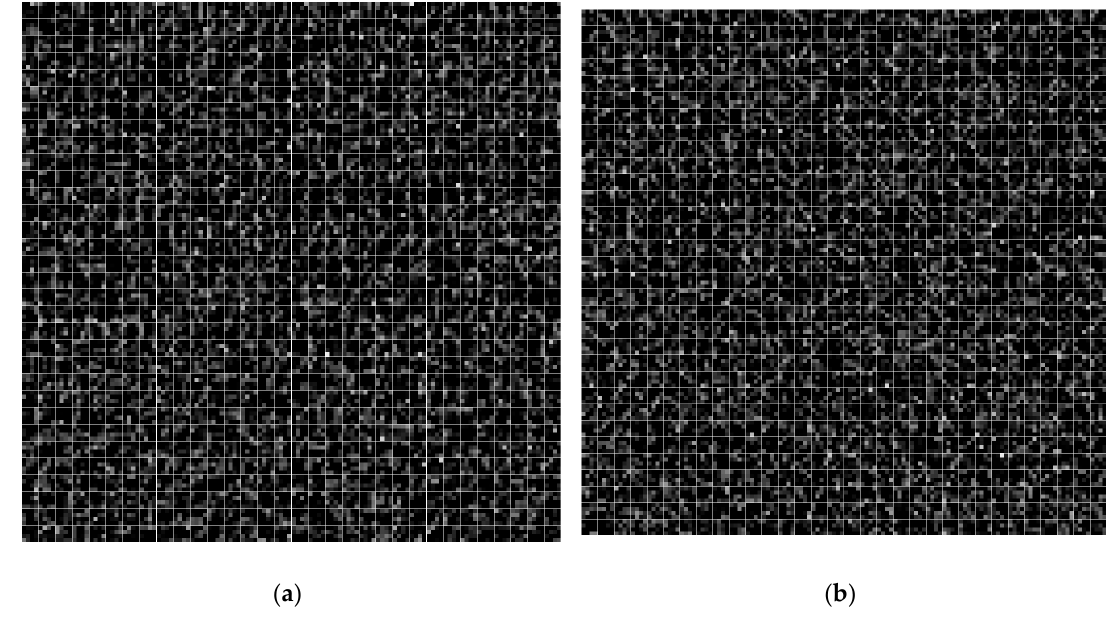
Figure 3. Trained high ‐ resolution dictionaries: ( a ) Nihonmatsu, ( b ) Yokohama.